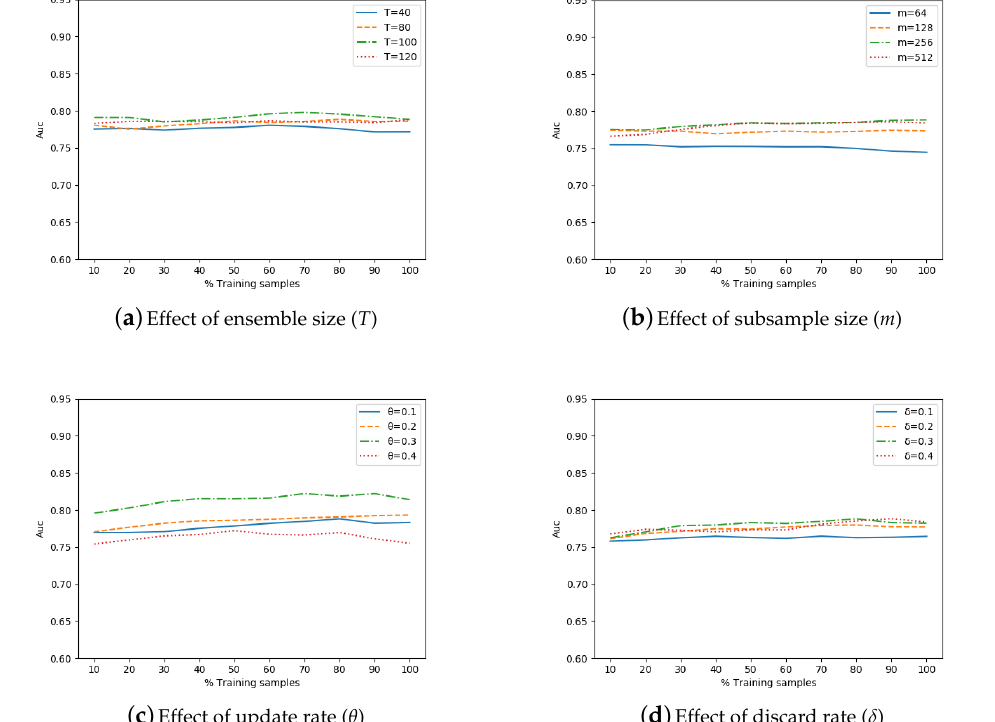
Figure 4. Effects of different ensemble sizes, subsample sizes, update rates, and discard rates on the detection